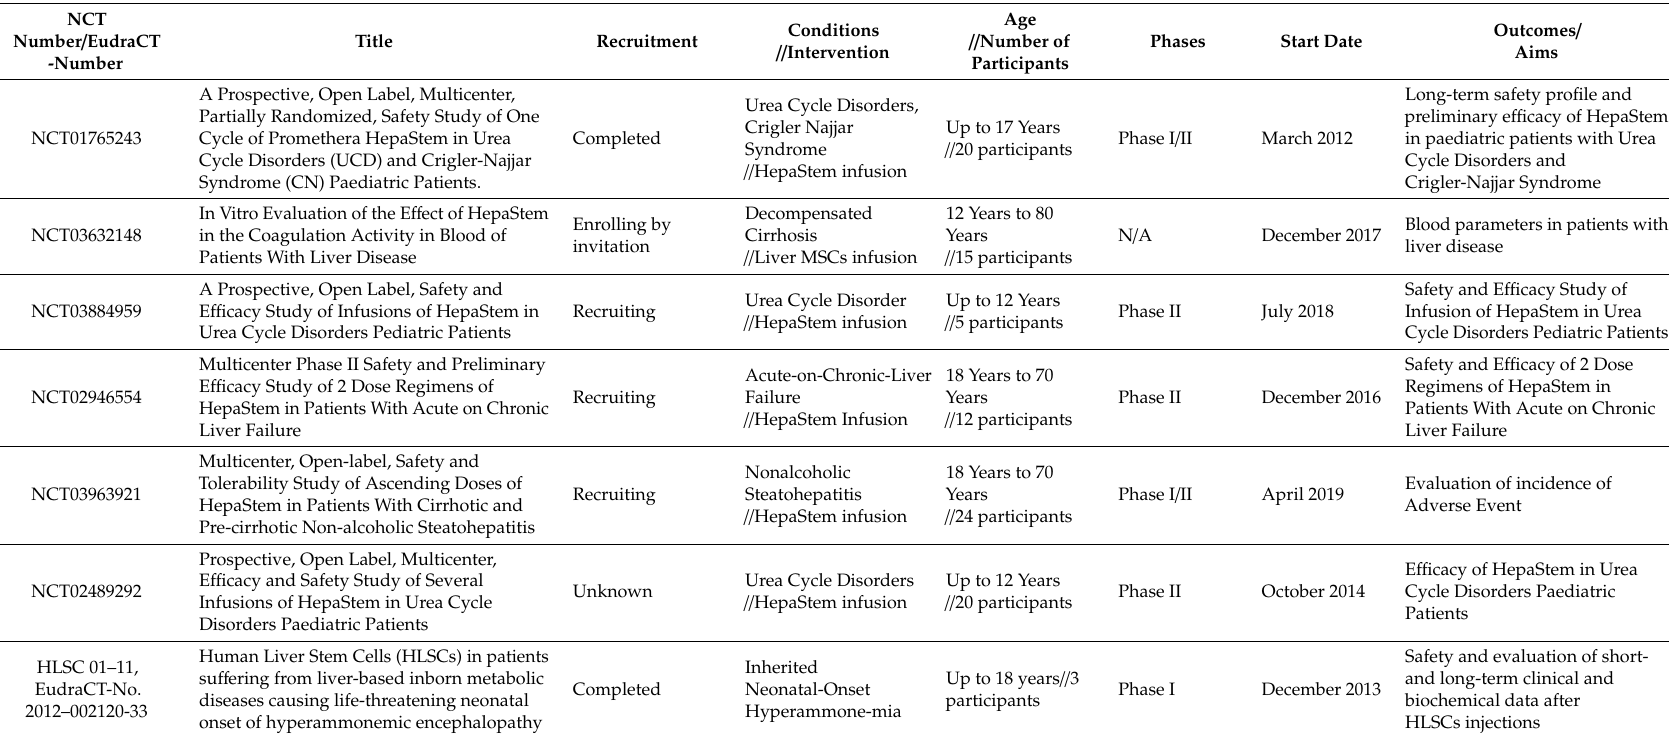
Table 2. Clinical trials with LSCs (source: https: // clinicaltrials.gov / and https: // www.clinicaltrialsregister.eu /